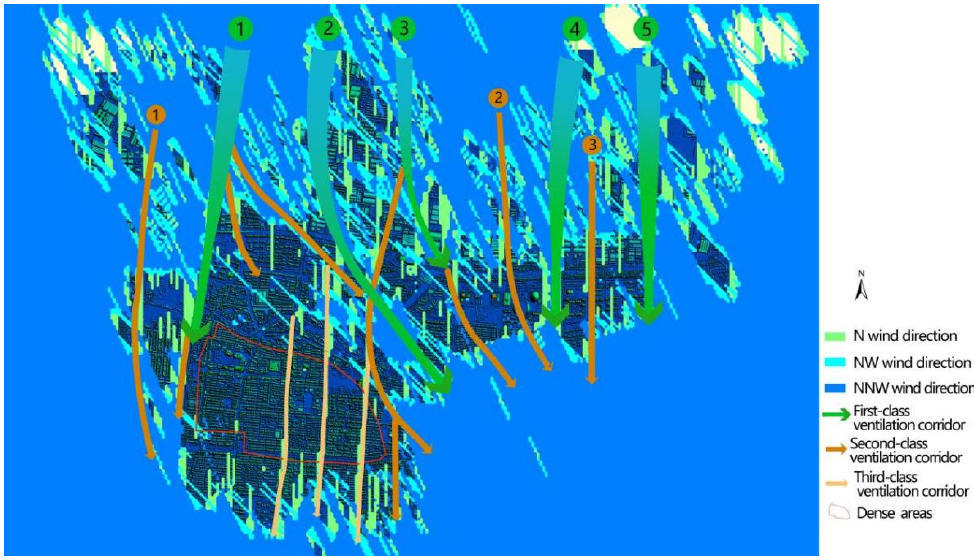
Figure 20. Results of the automatic mining of a 30 m width and 500 m corridor (DSM + corridor).